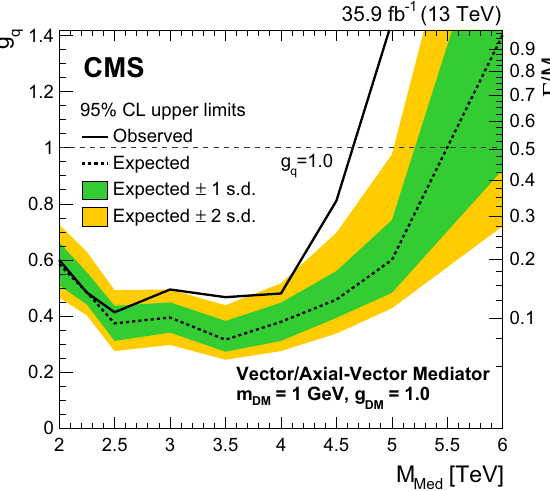
Fig. 3 The95%CLupperlimitsonthequarkcoupling g q ,asafunction of mass, for an axial-vector or vector DM mediator with g DM = 1 . 0 and m DM = 1GeV. The observed limits (solid), expected limits (dashed) and the variation in the expected limit at the 1 and 2 standard deviation levels (shaded bands) are shown. A dotted horizontal line shows the coupling strength for a benchmark DM mediator with g q = 1 . 0. The corresponding limits on the width of the mediators are shown on the vertical axis on the right-hand side of the figure